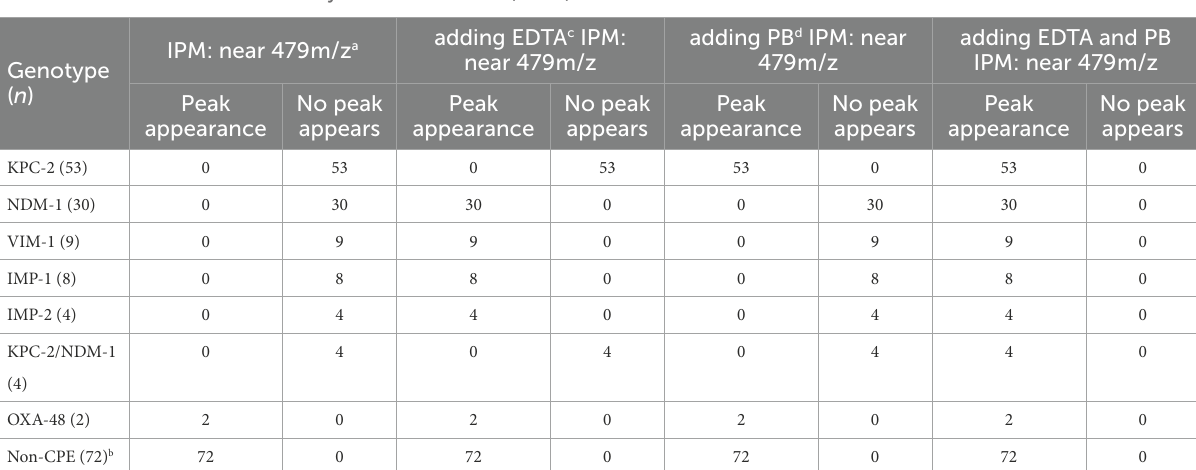
TABLE 2 CPE classification as detected by MALDI-TOF with IPM, EDTA, and